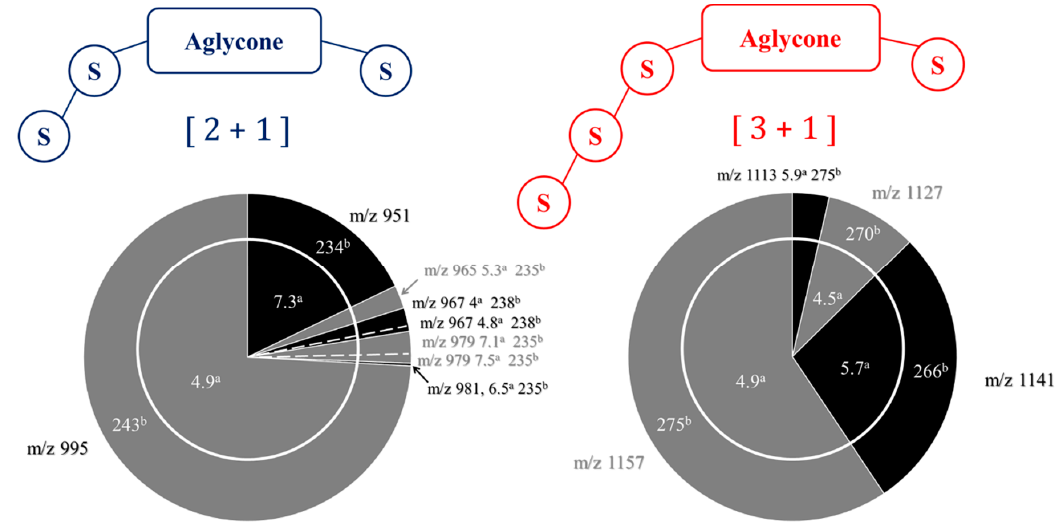
Figure 6. Molecular diversity of the three and four-sugar saponins from the quinoa extract. Integration of the MALDI-ToF, LC-MS(MS), and LC-IMS-MS data with ( a ) the retention times in LC (min) and ( b ) the collision cross sections in IMS (Å 2 ). Section areas are associated with LC-MS semi-quantitative analysis using Hederacoside C as the internal standard and correspond to molar proportions (% in the quinoa husk extract). The relative proportions are also given in Table 1.